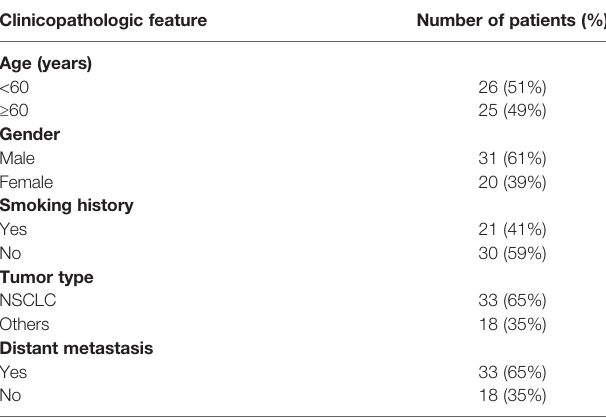
TABLE 1 | Baseline clinicopathological features of 51 patients with diverse